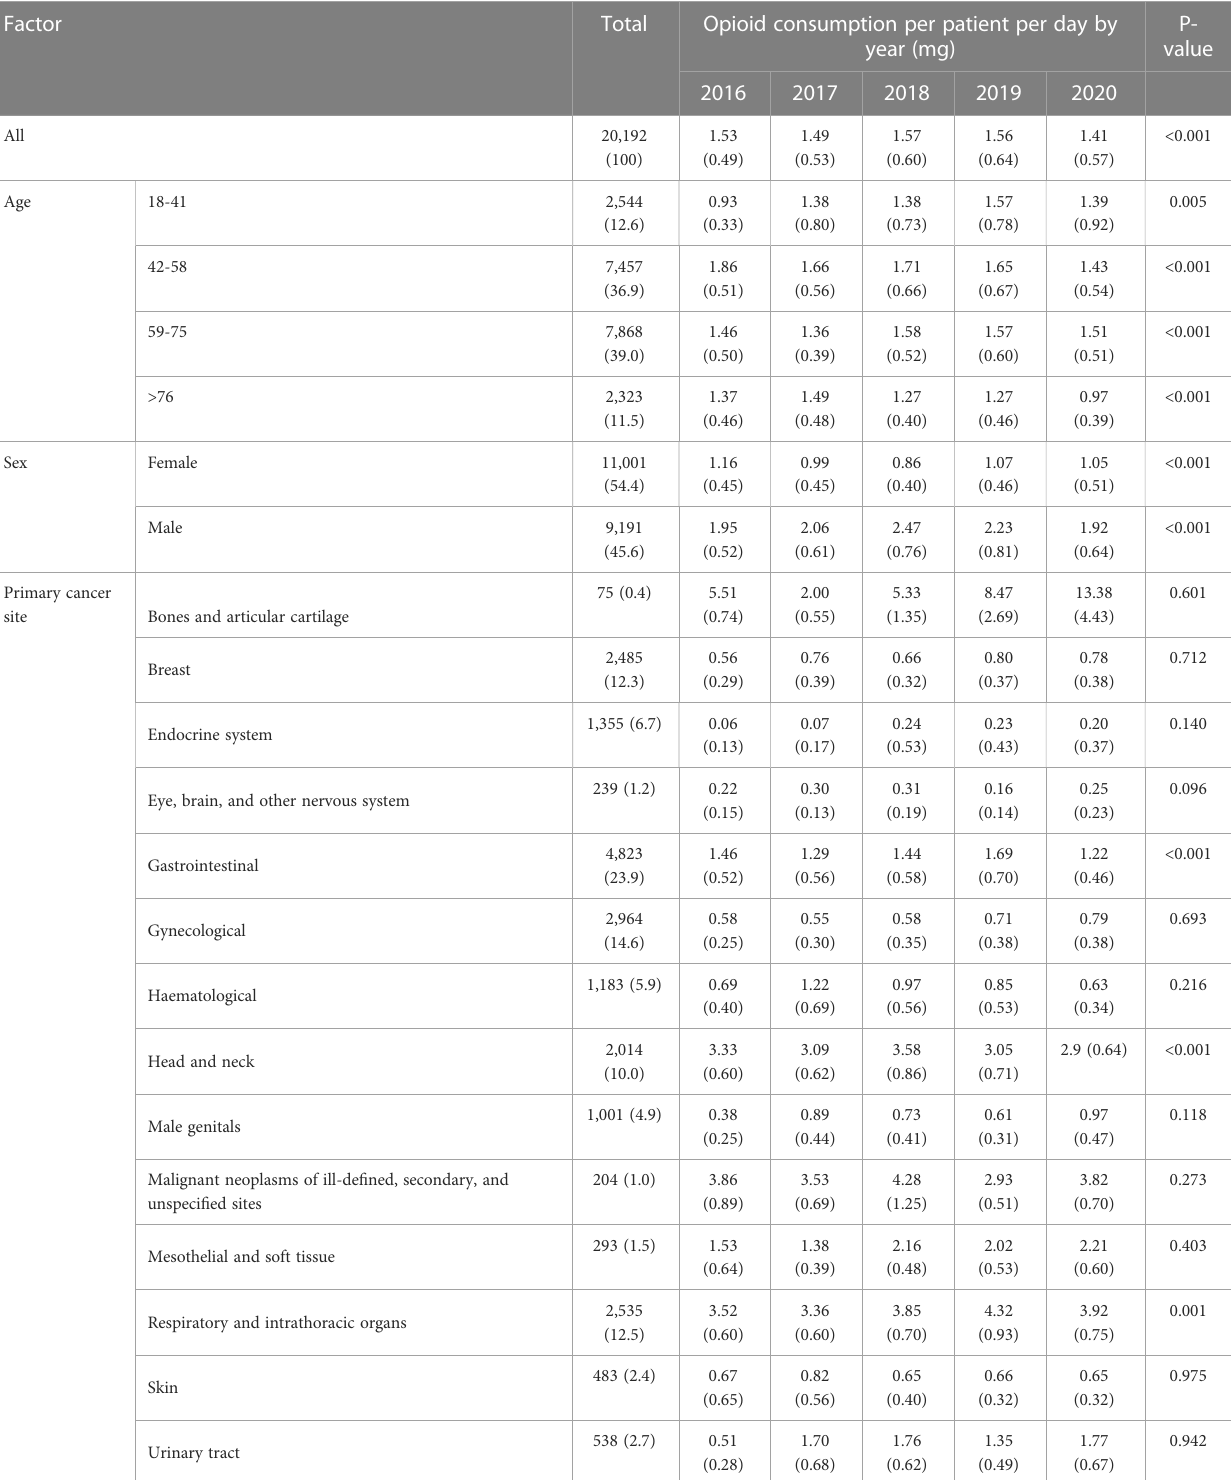
TABLE 1 Characteristic of cancer patients visiting the outpatient department and the opioid consumption per patient per day per year during 2016 – 2020 (N=20,192).